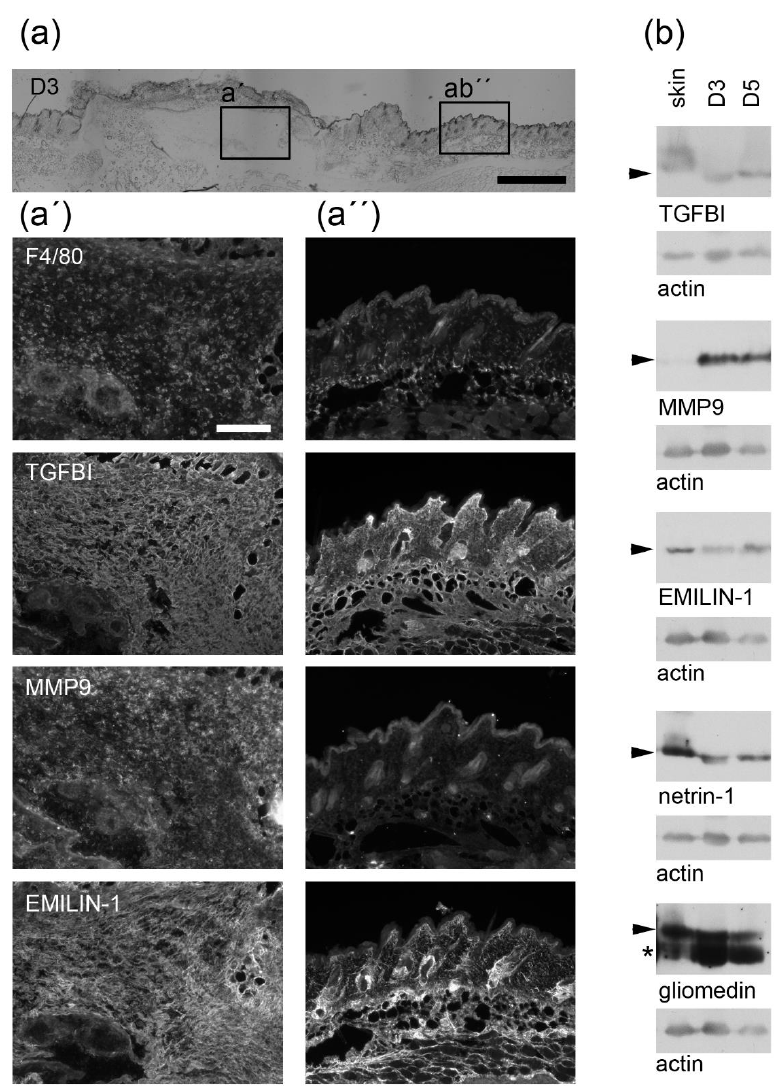
Figure 5. Validation of matrisome proteins in the in vivo wound bed in a murine wound healing model. ( a ) In wounds that were harvested three days post wounding the macrophage-specific F4/80 as well as transforming growth factor beta induced (TGFBI), MMP9 and EMILIN-1 were detected by immunofluorescence analysis within the wound ( a’ ) or the intact skin ( a´´ ). ( b ) TGFBI, MMP9, EMILIN-1, netrin-1 and gliomedin abundance (arrowhead) was analyzed by immunoblotting in lysates of intact skin (skin) or wounds three (D3) and five days post wounding (D5). Actin was used as loading control. As EMILIN-1 and gliomedin were tested on a single blot, the same actin control is included in both panels. Molecular weights of Thermo Scientific™ PageRuler™ Plus Prestained 10– 250 kDa Protein Ladder bands are given. *, unspecific band; scale bars ( a ), 1000 µm; ( a´ , a´´ ), 200